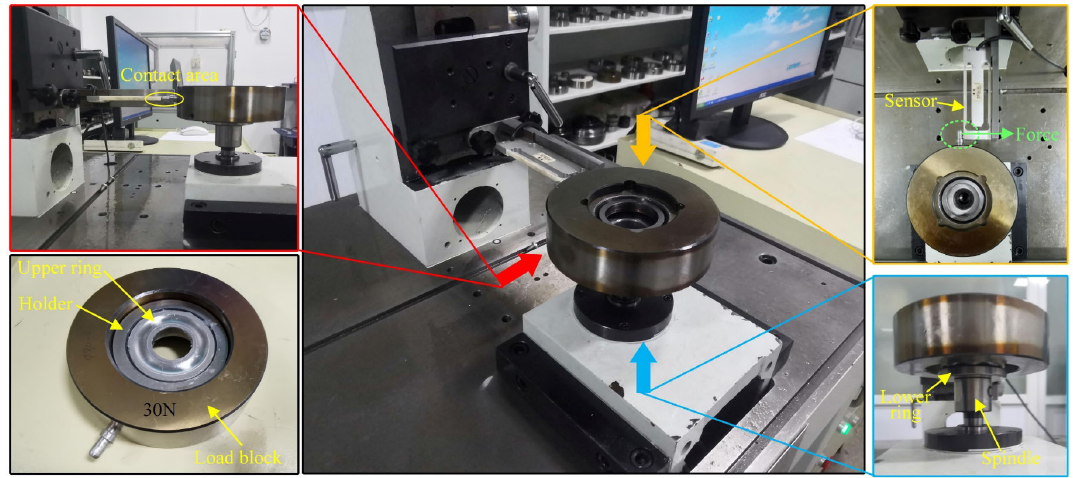
Fig. 5 Friction torque